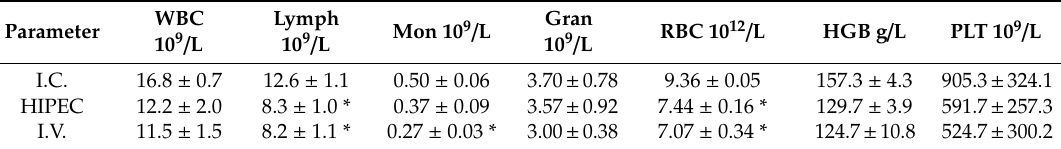
Table A1. Hematological parameters in blood of animals at 5th day of experiment. Calculated as average for 3 rats ( n = 3) ±